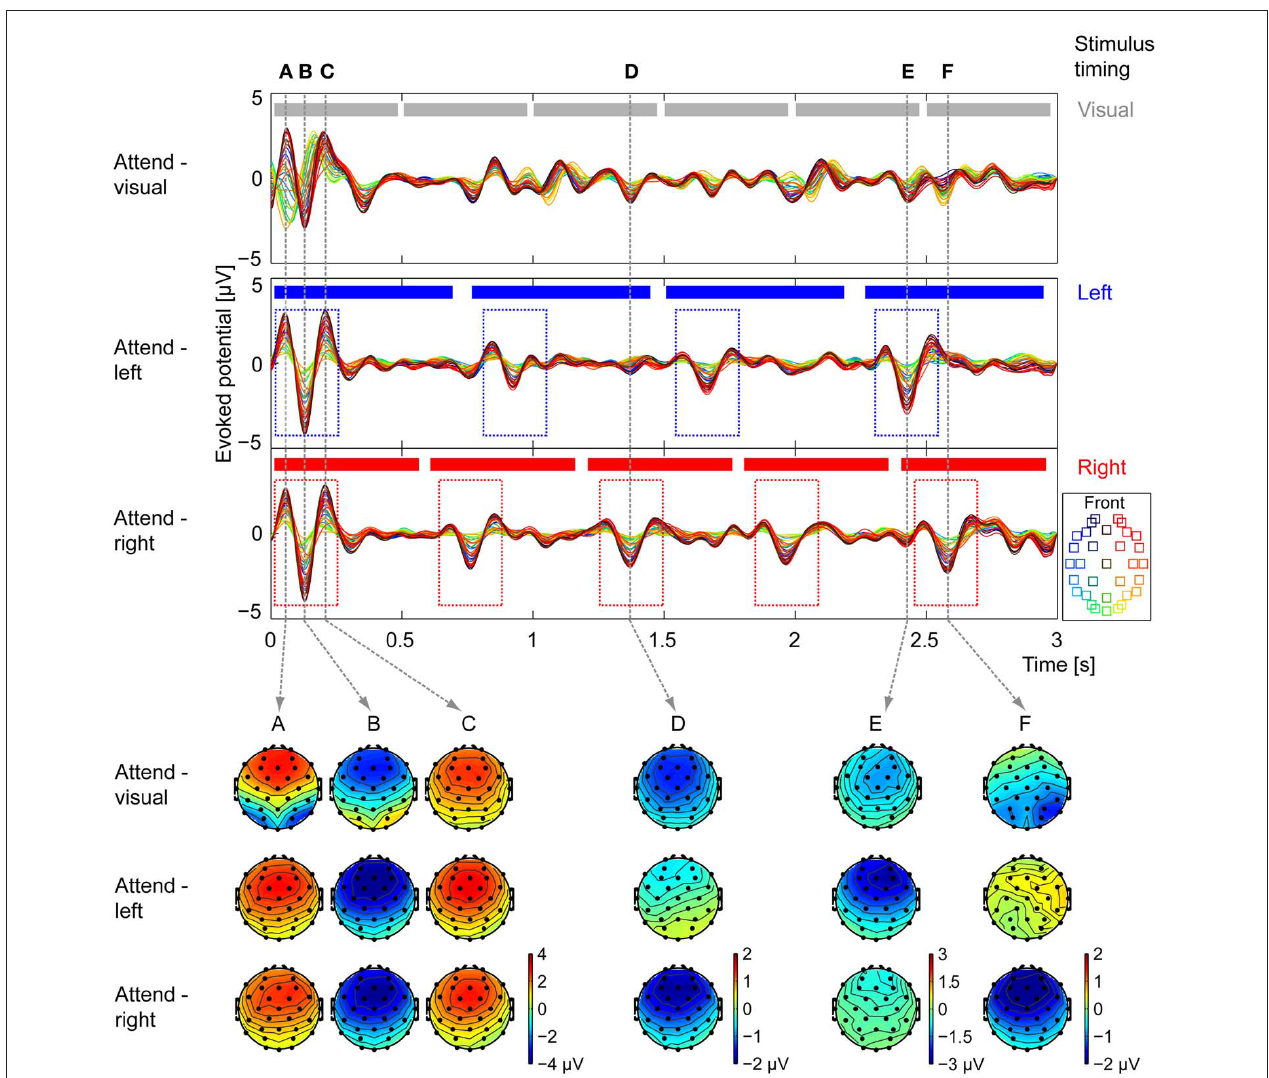
FIGURE 4 | Grand average ERP waveforms and topographies. Average EEG waveforms evoked by the stimulus are plotted for each of the 32 electrodes (see legend for electrode location) in each of the attentional conditions (top: attend-visual, middle: attend-left, bottom: attend-right). At the top of each panel, the events in the attended stream are shown (gray, top panel: visual arrows; blue, middle panel: four notes of the left auditory stream; red, bottom panel: five notes of the right auditory stream). For attend-left and attend-right conditions, onset responses are seen following the note onsets of the attended stream (see dashed blue and red boxes in middle and bottom panels, respectively). The scalp topographies in each of the attentional conditions are shown for six key times, marked (A–F) by vertical dashed lines, that correspond to strong evoked responses in one or more conditions. (A–C) Times corresponding to auditory-evoked P1, N1, and P2 to the stimulus onset, respectively. Attend-left and attend-right conditions have nearly identical topographic patterns, with maximum amplitudes in